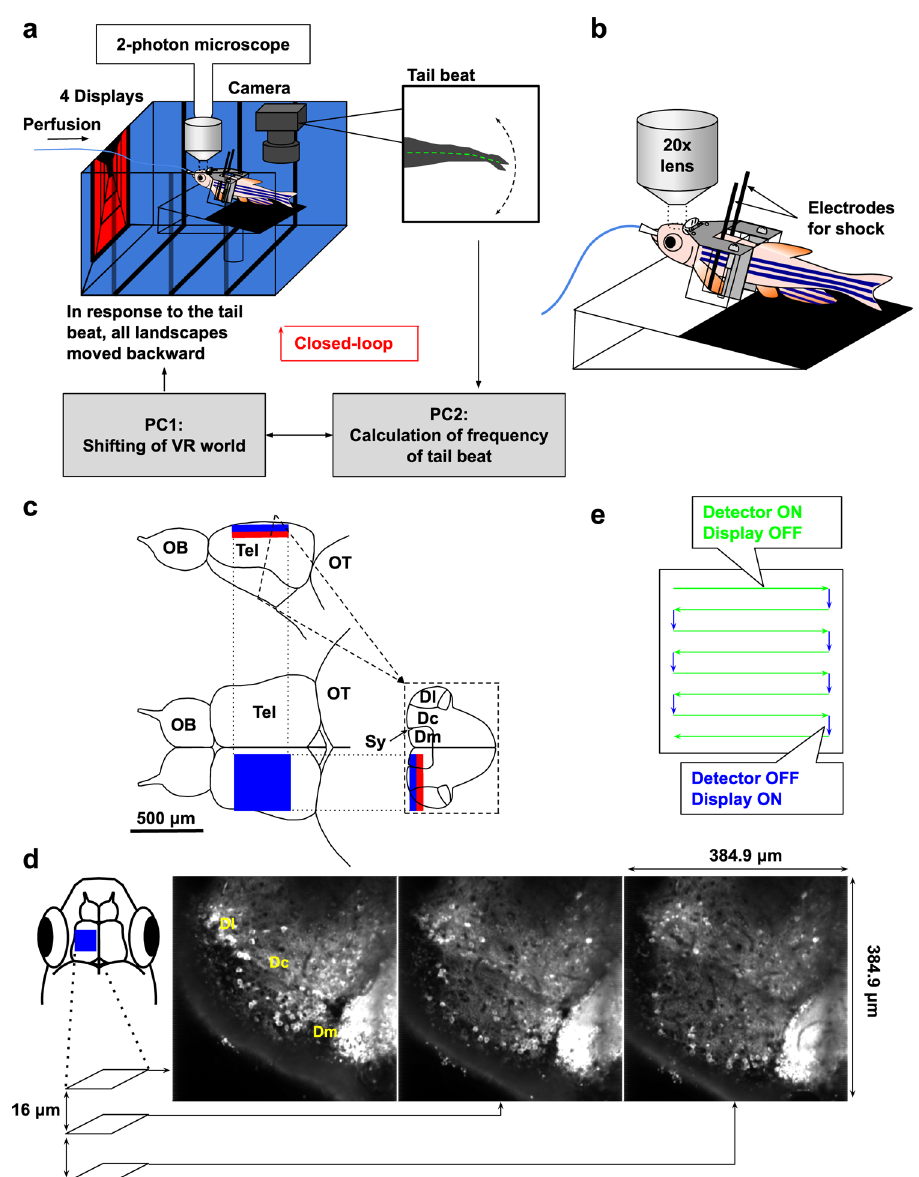
Fig. 1 The closed-loop virtual reality two-photon imaging system enables real-time capturing of neural activity in adult zebra fi sh. a Schematic diagram of the closed-loop virtual reality setup. Four displays presented visual stimuli. Tail beating was captured by a camera and caused the scenery to move backward to create the impression of forward swimming. The virtual traveling distance was calculated by [frequency of tail beats] × [gain]. b Schematic drawing of the tethered adult zebra fi sh using a custom-made harness, dental bond, and cement. Two needle electrodes were placed on both sides of the body to deliver electric shocks. c The imaged region in the telencephalon. The side (top) and dorsal (bottom left) views and coronal section (bottom right) of the adult zebra fi sh brain. The blue box indicates the imaged region by surface three-plane imaging, and the red box indicates the additionally imaged region by six-plane imaging. Dc, central zone of dorsal telencephalic area; Dl, lateral zone of dorsal telencephalic area; Dm, medial zone of dorsal telencephalic area; OB, olfactory bulb; OT, optic tectum; Sy, sulcus ypsiloniformis; Tel, telencephalon. d Calcium imaging of neural activity in three focal planes using the piezo actuator. Either left or right hemisphere was imaged. These images are averaged images of the left hemisphere in three focal planes. Anterior to top; lateral to left; medial to right. Dl, lateral zone of the dorsal telencephalon; Dc, central zone of dorsal telencephalon; Dm, medial zone of dorsal telencephalon 10 . e Schema of alternate switching of neural activity detection by a two-photon microscope and visual stimulation by displays. Green arrows indicate the duration of scanning; in this setting, the detector is ON and displays are OFF. Blue arrows indicate the duration from the end of a line scan to the onset of the next line scan; in this setting, the detector is OFF and displays are stay in the red region for 10 s. If the fi sh did not behave as (Fig. 2a). After the inter-trial interval (15 s) when fi sh perceived indicated by the given task conditions, an electric shock (5 V/cm white color with black stripes on the surrounding areas of the for 1 s) was delivered from two needle electrodes on both sides of displays, the GO or NOGO task was randomly initiated. In the the body (Fig. 1b). The fi sh had to determine whether to move GO task, the surrounding color turned blue, and fi sh had to forward or to stay depending on the presented color to avoid escape to the red region in front of them within 10 s. For the electric shock. NOGO task, the surrounding color turned red, and the fi sh had to